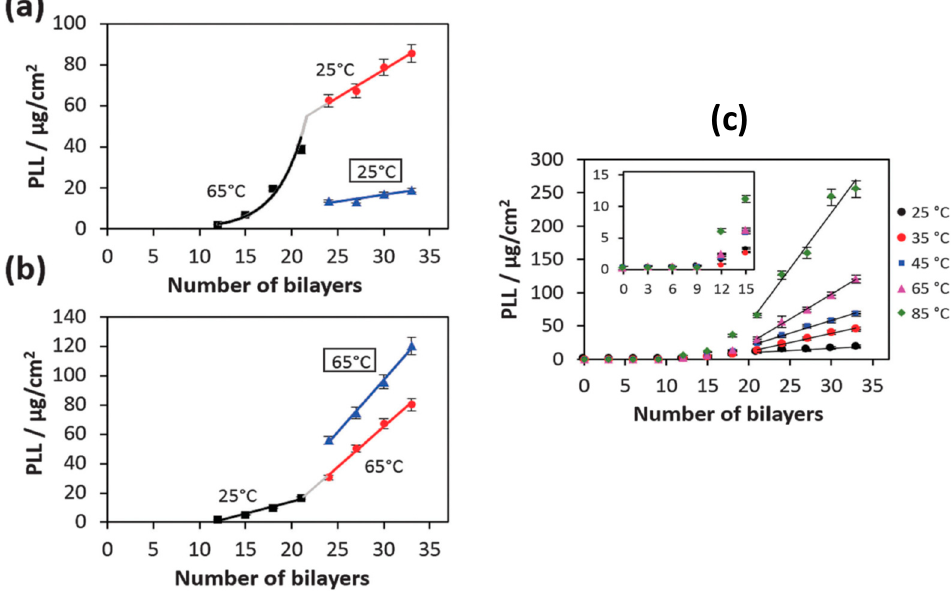
Figure 8. ( a ) Temperature change from 65 ◦ C to 25 ◦ C; ( b ) Temperature change from 25 ◦ C to 65 ◦ C at the 21st bilayer. The blue triangles represent film preparation at 25 ◦ C and 65 ◦ C without the temperature change after 21 bilayers. ( c ) Mass coverage of PLL in the HA / PLL film formed at di ff erent temperatures. The inset shows the enlarged growth profile until 15 bilayers. Figure taken from reference [141], copyright © 2020 Published by the PCCP Owner Societies.